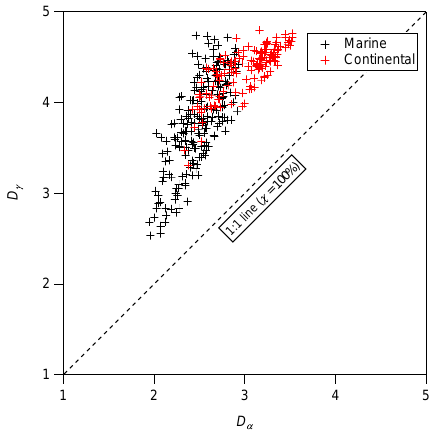
Figure 10. Mixing state diagram demonstrating the relationship be- tween average single particle diversity ( D α ) and bulk population diversity ( D γ ) during periods influenced by marine and continental air